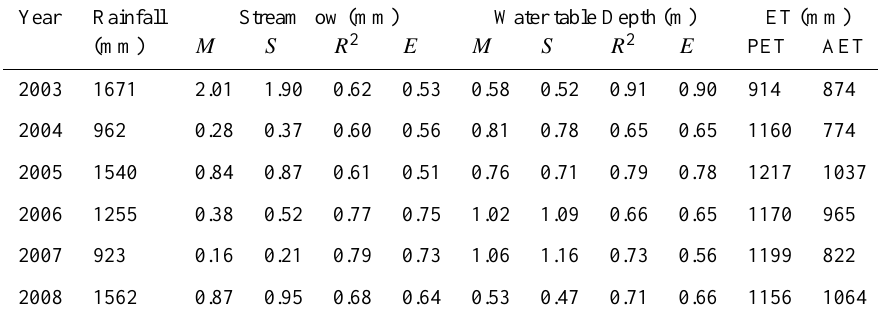
Table 1. Measured vs. simulated streamflow, water table and ET a . Year Rainfall Streamflow (mm) Water table Depth (m) ET